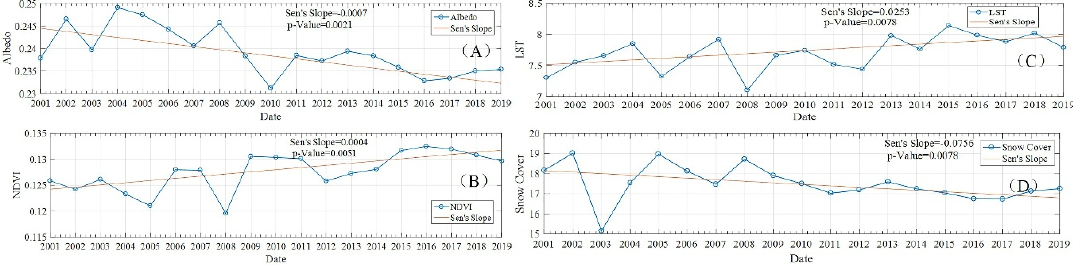
Figure 6. The decadal variability of yearly land surface albedo ( A ), NDVI ( B ), LST ( C ), and the fraction of snow cover ( D ) for the mountainous terrain over the years 2001 to